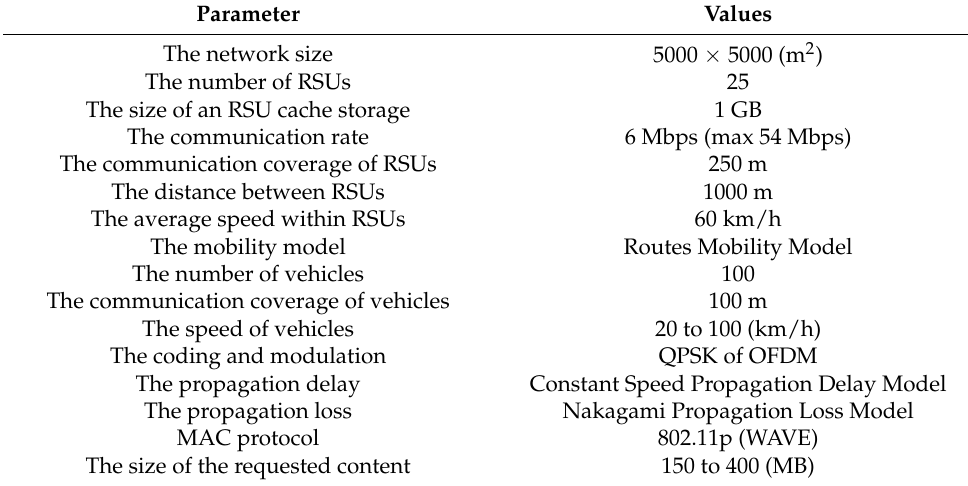
Table 3. Simulation